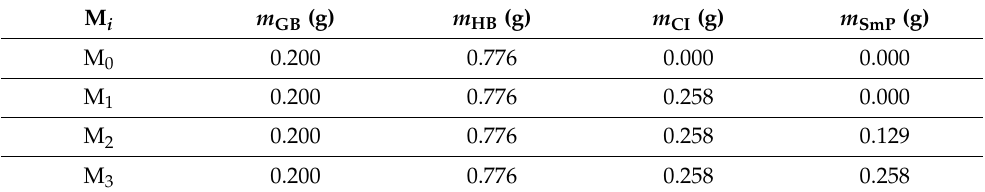
Table 3. Volumes and volume fractions for the components of membranes M 𝑖 (𝑖 = 0,1,2,3) .